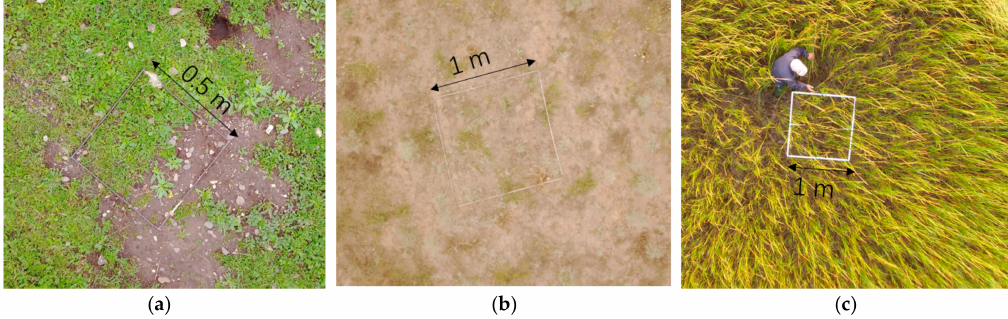
Figure 5. A quadrat with frame in the Gansu ( a ), Inner Mongolia ( b ), and Jiangsu study sites ( c